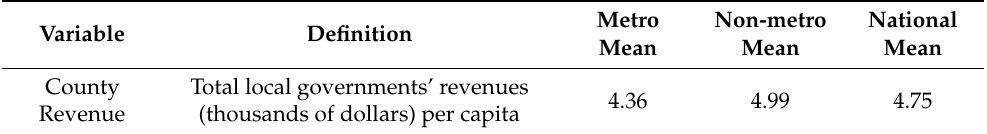
Table A12. Local governments’ total revenues per capita in a